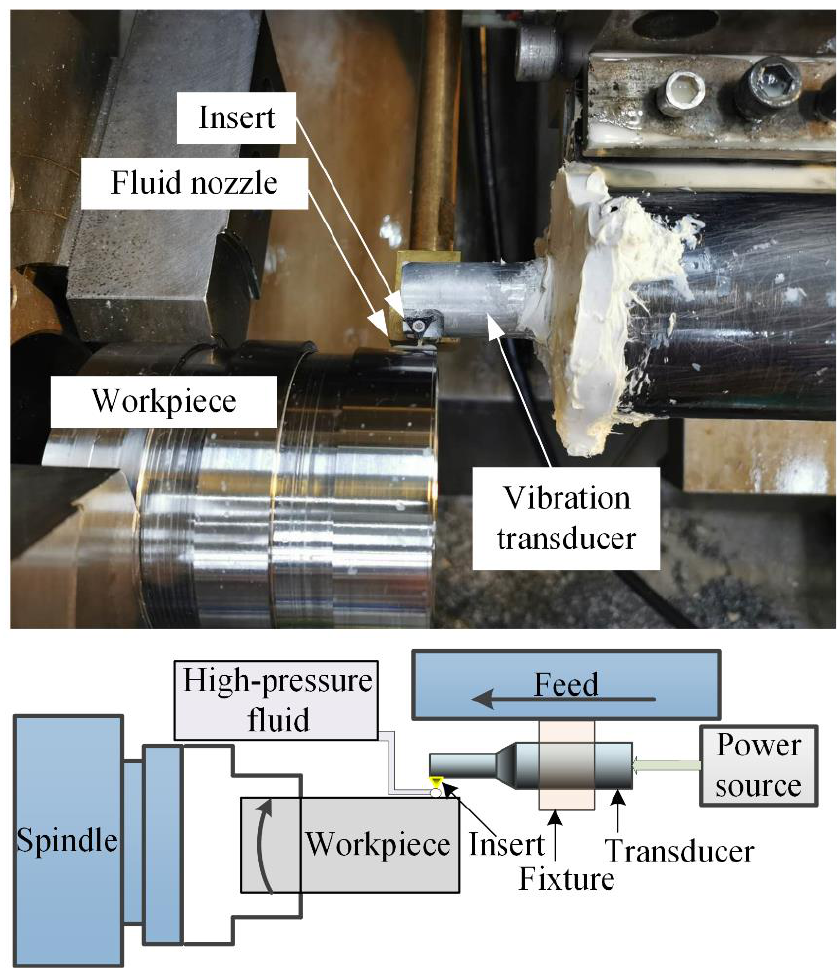
Figure 5. Setup for the tool life experiment.